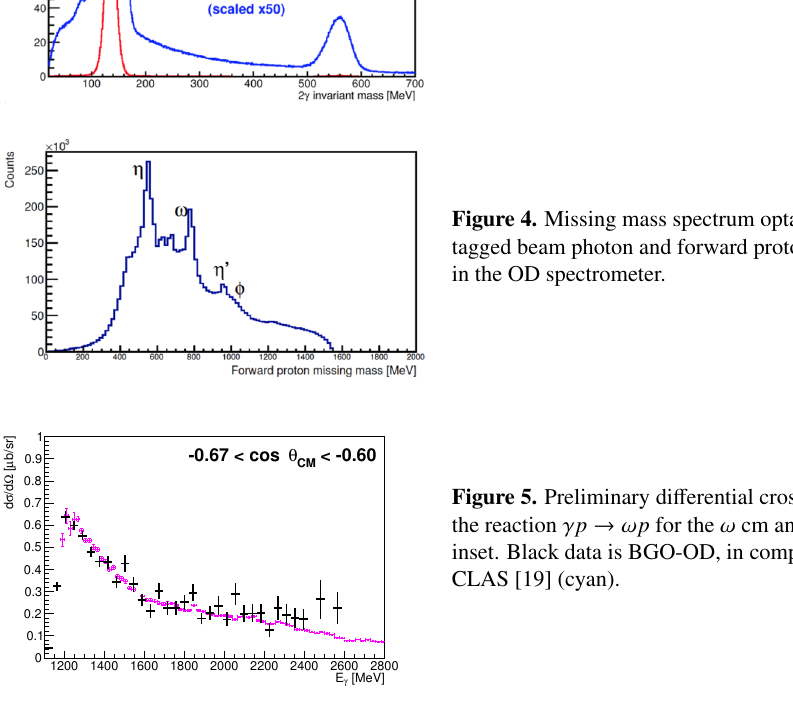
Figure 3. Two-photon invariant mass spectrum taken with the central BGO calorimeter.